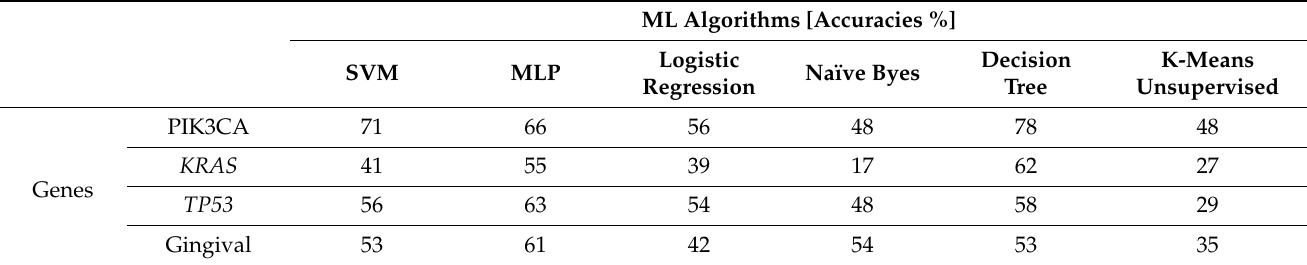
Figure 2. Machine Learning accuracies for vivid datasets exploited using various experiments. Table 1. ML Accuracies for each Oral Cancer Gene. Table 2. Accuracies through 5-fold classification on different algorithms for the 4 genes.